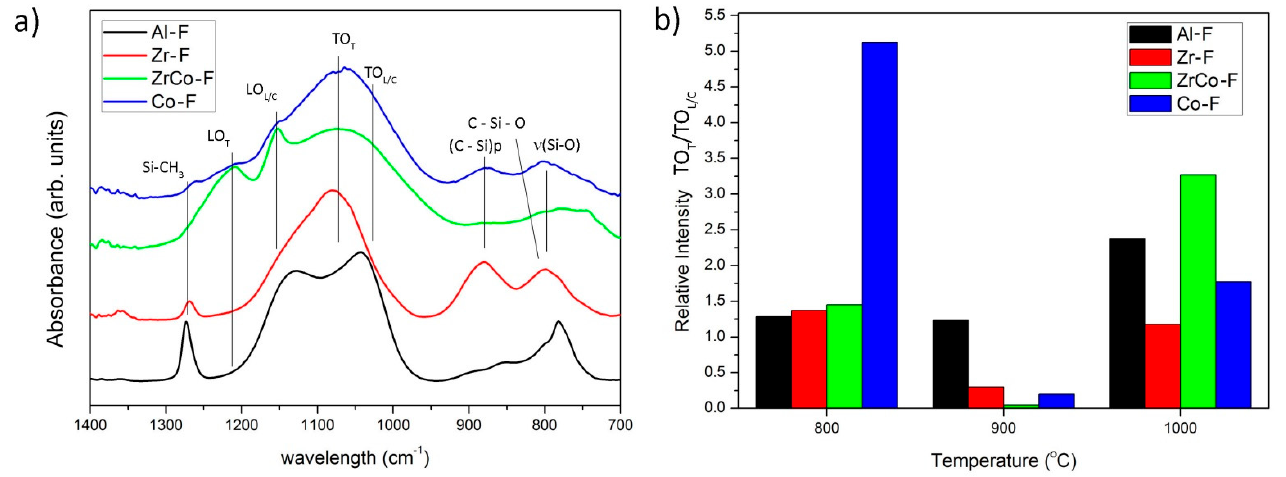
Figure 3. ( a ) FTIR spectra (in the absorbance mode) of the HF samples pyrolyzed at 900 °C and ( b ) the relative intensity ratio of the TO 4 /TO 6 modes of the HF-etched samples.